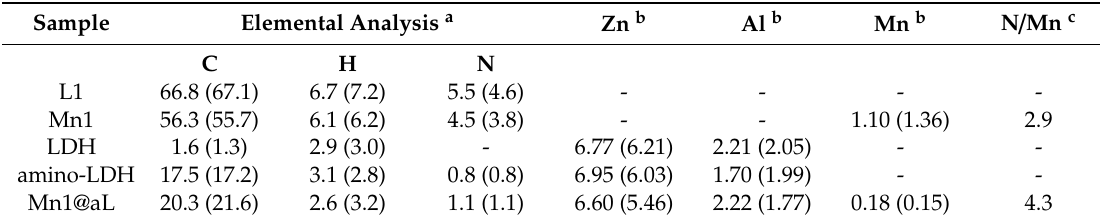
Table 2. Chemical composition data of synthetic samples.